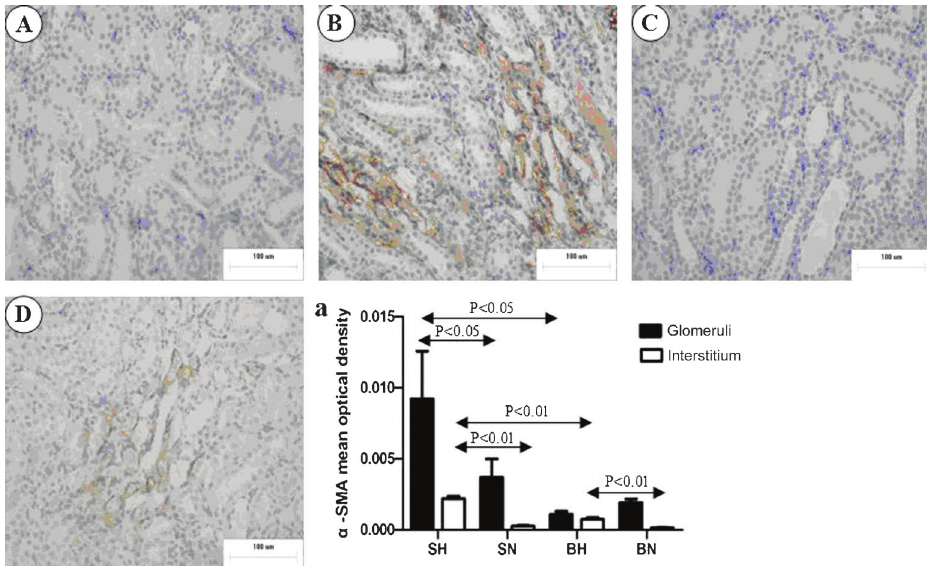
Figure 4. Representative images of immunostaining for a -SMA in renal medulla of all groups. A , SN group; B , SH group; C , BN group; D , BH group. a , Positive immunostaining of a -SMA was quantified in both glomeruli and interstitium. SN: Dahl salt-sensitive (SS) rats on a normal-salt diet (0.3% NaCl); SH: Dahl SS rats on a high-salt diet (8% NaCl); BN: SS-13 BN rats on a normal-salt diet (0.3% NaCl); BH: SS-13 BN rats on a high-salt diet (8% NaCl). One-way ANOVA was used for statistical